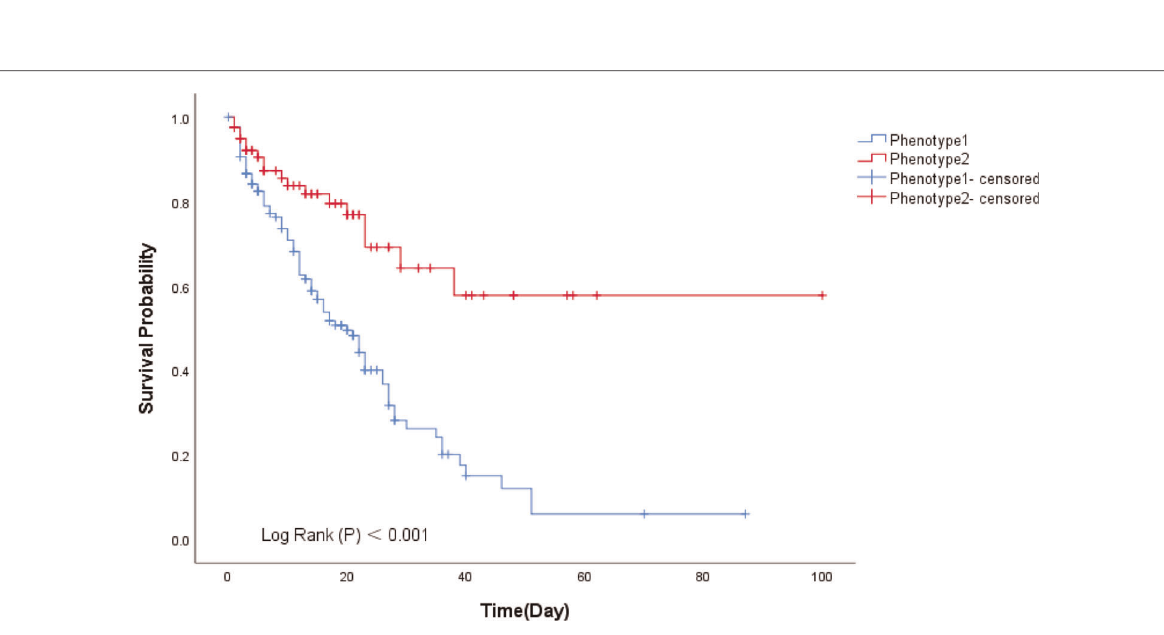
FIGURE 4 Categorical variables of different subphenotypes. HFOV, high frequency oscillation; CRRT, continuous renal replacement therapy; IAG, in fi ltration area grade.